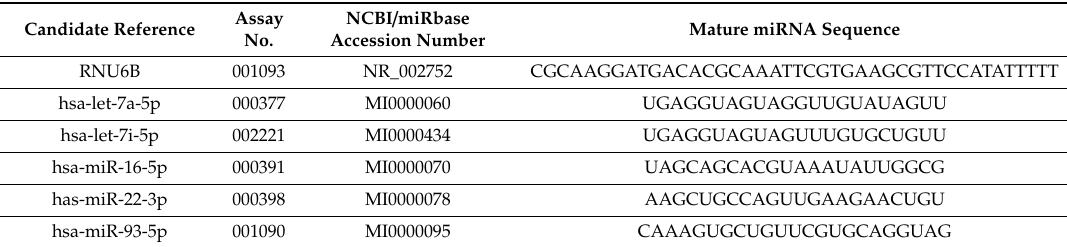
Table 1. TaqMan ® miRNA assay